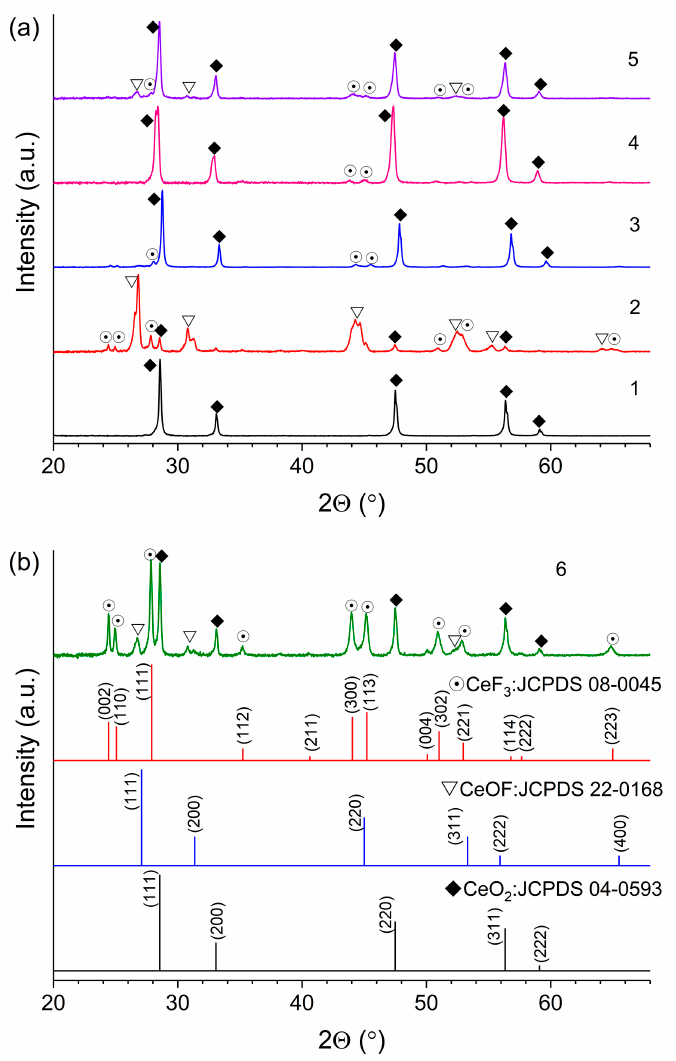
Figure 2. XRD patterns of samples 1–6. The (hkl) indices of the CeO 2 ( ), CeF 3 ( ), and CeOF ( ) structures are labeled for the samples. ( a ) XRD patterns of samples 1–5, ( b ) XRD pattern of the sample 6 and standard data (JCPDS no. 08-0045, JCPDS no. 22-0168 and JCPDS no. 04-0593).